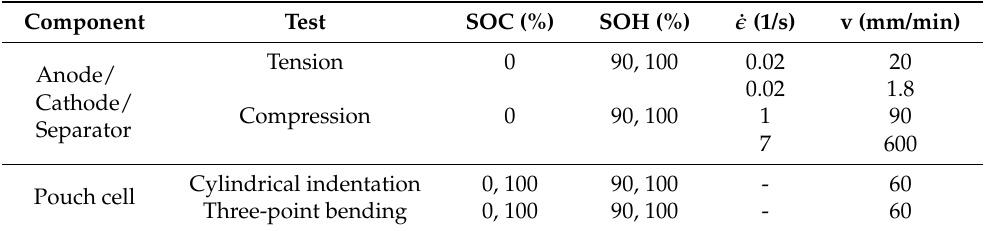
Table 1. Mechanical tests for the characterization of the investigated lithium-ion pouch cell and cell